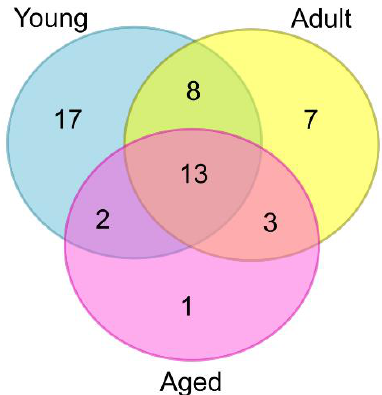
Figure 2. Venn diagram showing the number of fungal taxa (ASVs) found predominantly in each macaque age group (diagram produced using web-based software at: https://www.vanderpeerlab.org/?q=tools/venn-diagram (16 September 2022).